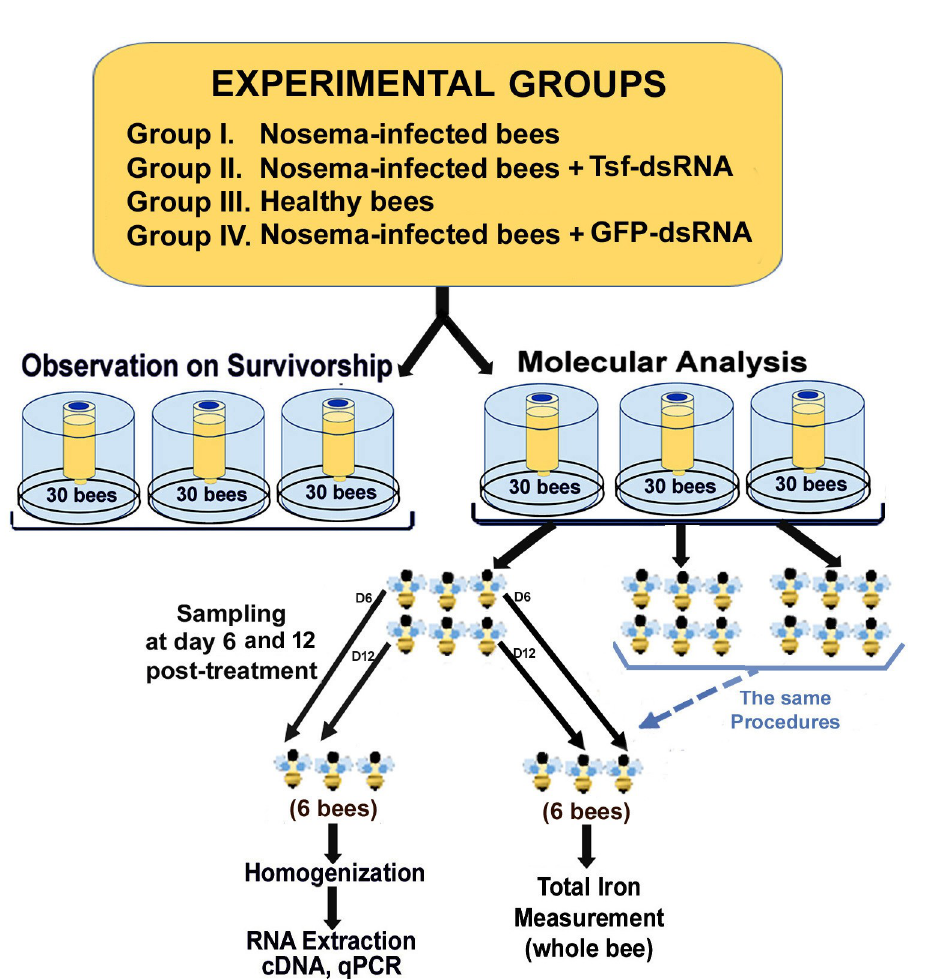
Fig 2. Graphic representation of the study design for laboratory cage